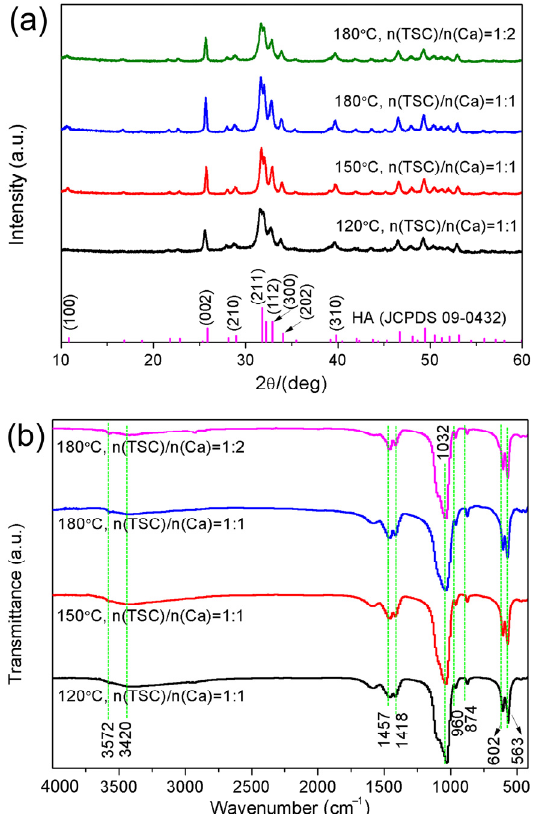
Figure 1. XRD pa tt erns ( a ) and FTIR spectra ( b ) of the powder prepared by TSC and urea under Figure 1. XRD patterns ( a ) and FTIR spectra ( b ) of the powder prepared by TSC and urea under di ff erent hydrothermal reaction temperatures and molar ratios of TSC/Ca. different hydrothermal reaction temperatures and molar ratios of